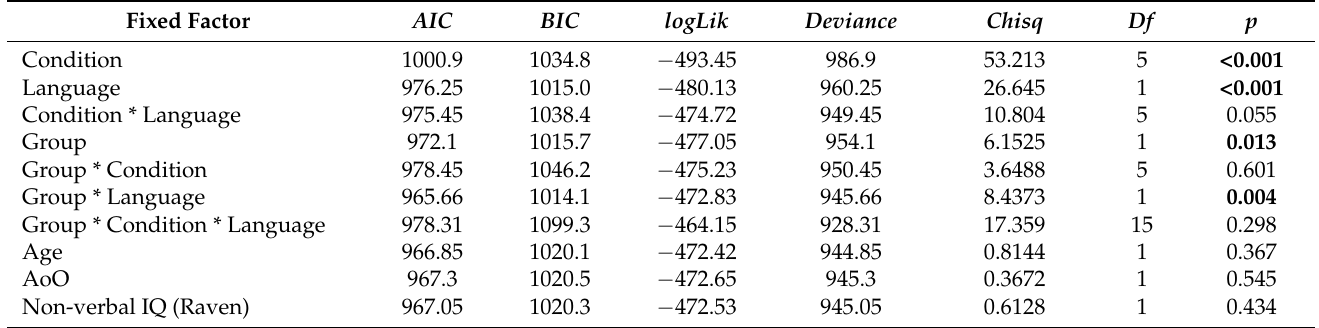
Table A1. Estimates of the GLMM model predicting the frequency of non-targeted CS by CS condition.